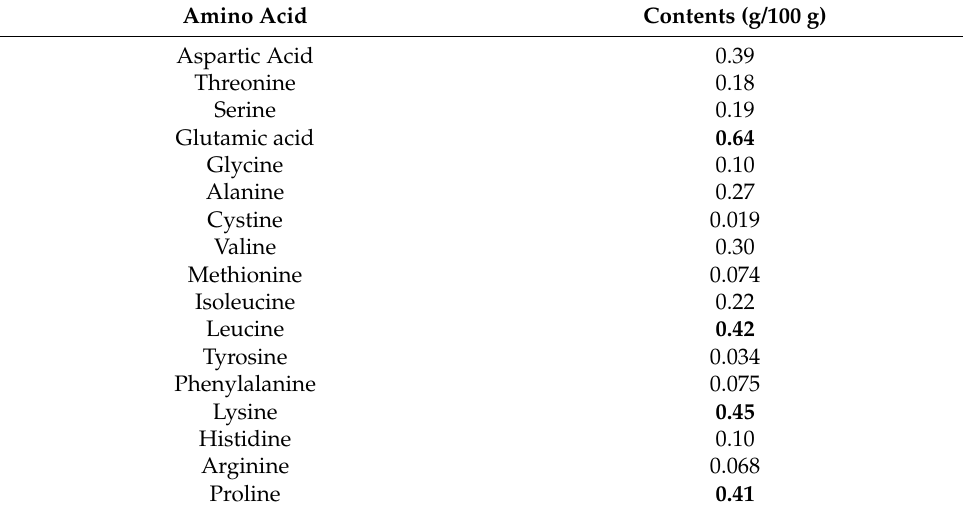
Table 3. The amino acid contents of